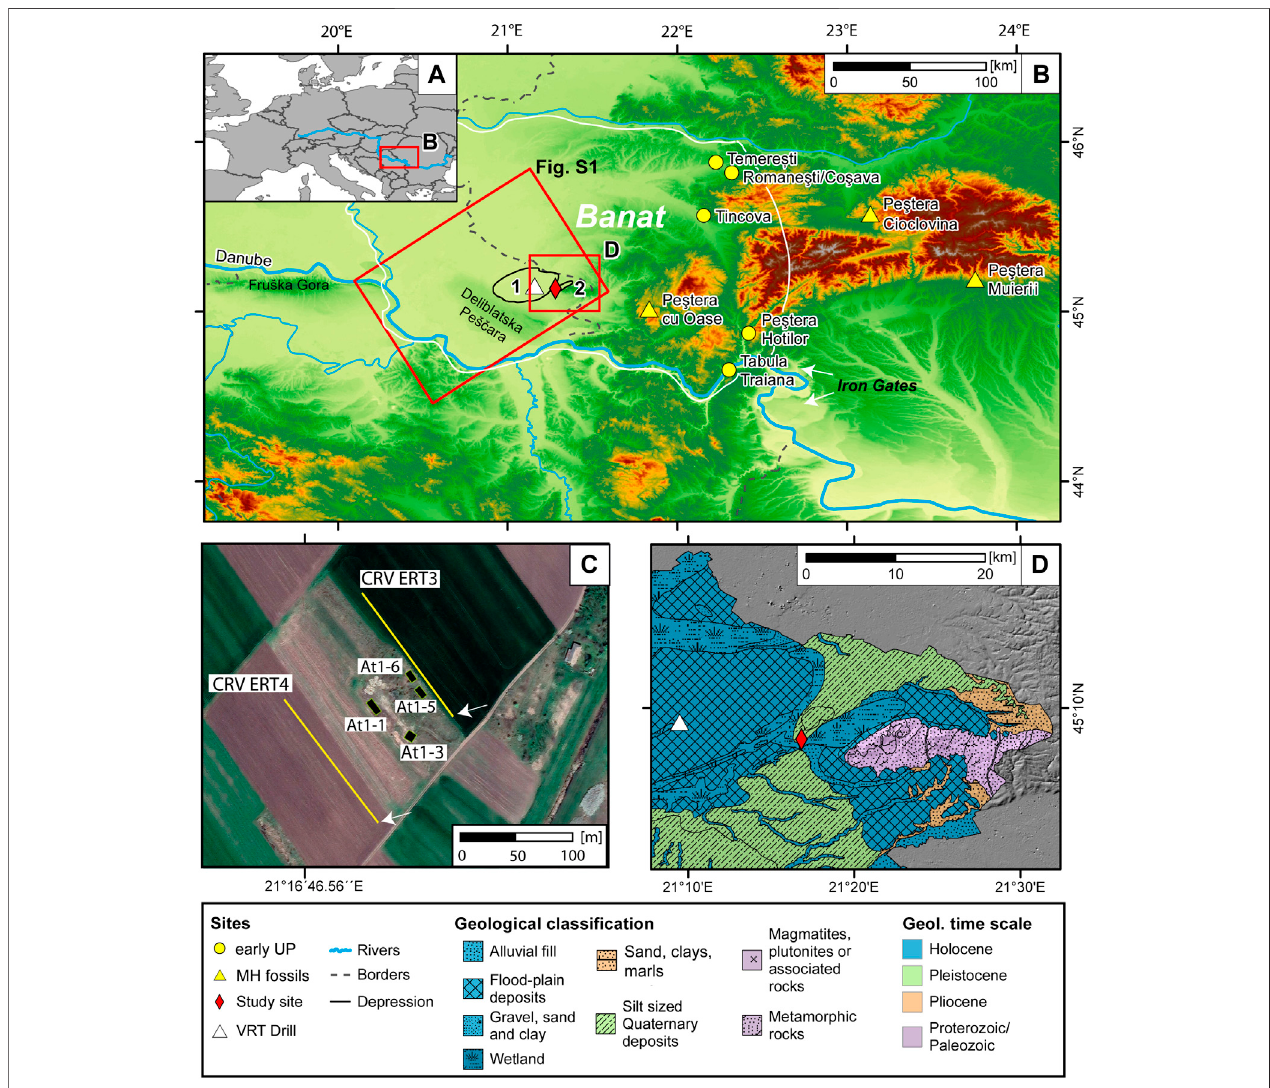
FIGURE 1 | Location (A – C) and geology (D) of the research site Crvenka-At (red diamond) east of the Deliblatska Pe ˇ s ˇ cara dune fi eld and the Alibunar Depression (1) and west of the Vr ˇ sac Mountains (2; map B) . The site is located at the border to two morphological depressions (black lines). Several sites that contain early Upper Palaeolithicartifactsareindicated(yellowcircles).Cavescontainingearlymodernhumanremainsaremarkedwithyellowtriangles.Furthermore,thelocationoftheVr ˇ sac borehole is shown (white triangle; Zeeden et al., 2021). The ALOS Global Digital Surface Model (AW3D30) builds the basemap for the surface elevation ©JAXA (JAXA EORC, 2016). The extend of Figure S1 is indicated (red rectangle). The Banat region is located within the white lines. Map (C) shows a close-up of the At I site including theERTtransectsand the excavation trenches. The arrows indicate electrodes 48ofeach transect.The google basemap (Bilder © 2020CNES/Airbus, Maxar Technologies, Kartendaten © ) shows a satellite photo. The geological map in D uses the map provided by the Geological Institute of Serbia, 2009.